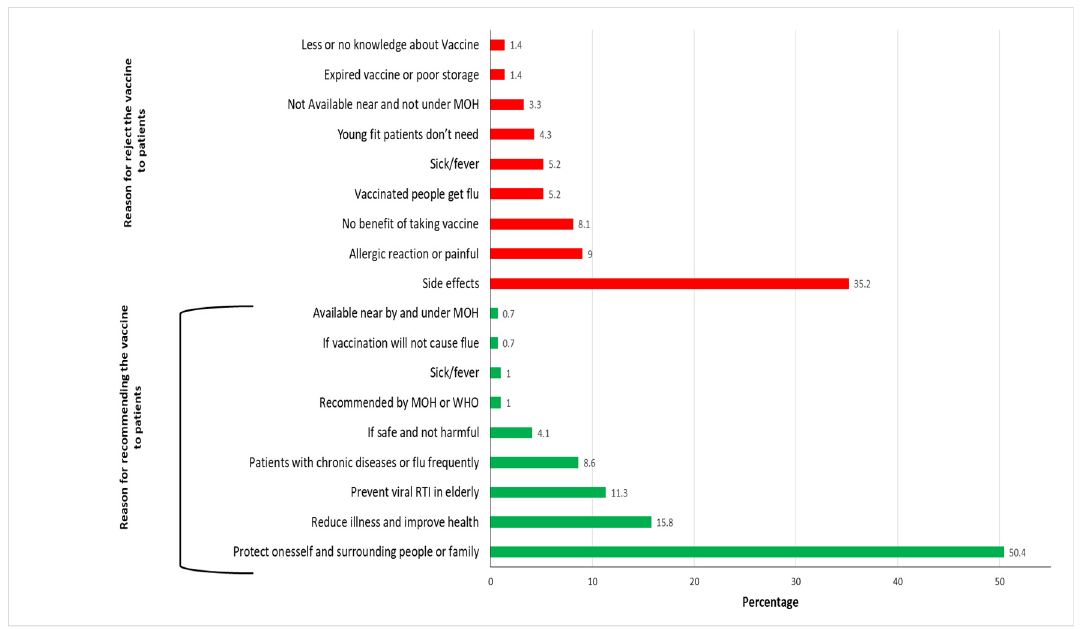
Figure 4. The reasons for recommending and rejection of the vaccine to patients.